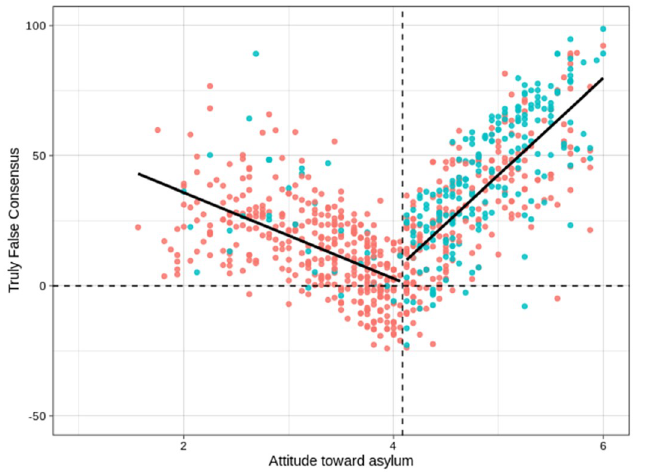
Fig 1. Truly false consensus scores by attitudes towards political